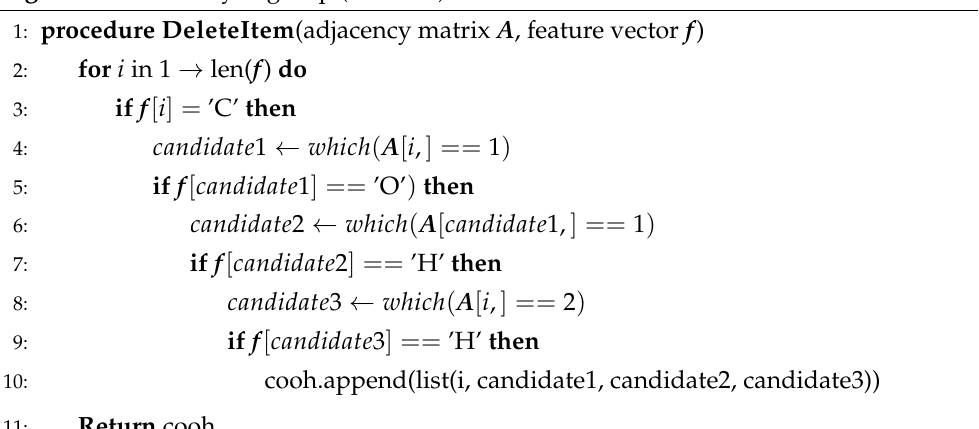
Algorithm 1 Carboxylic group (–COOH)